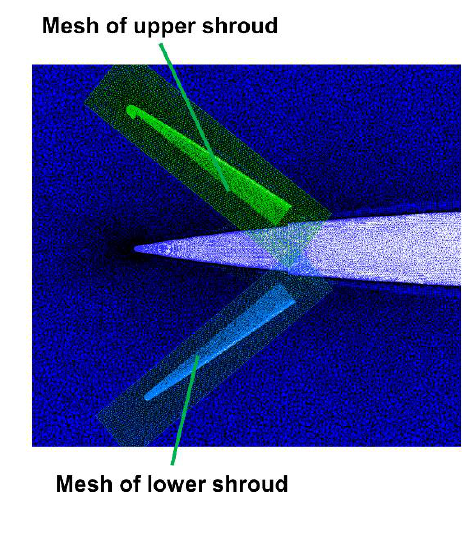
Figure 6. The surface mesh of the vehicle and shrouds: ( a ) surface mesh of the vehicle; ( b ) surface mesh of the shrouds.